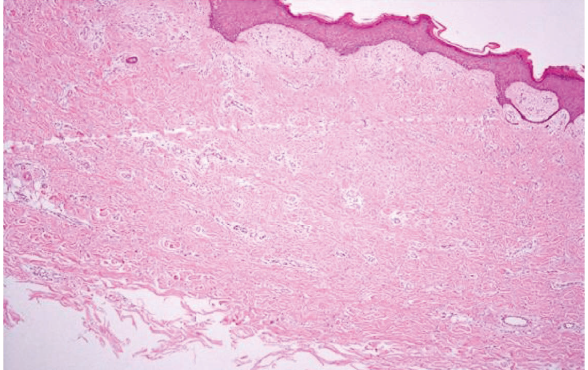
Figure 2: Histopathology of the large plaque with H&E stain at 40 x magnification. Dermatofibroma with the overlying grenz zone and epidermal hyperplasia.